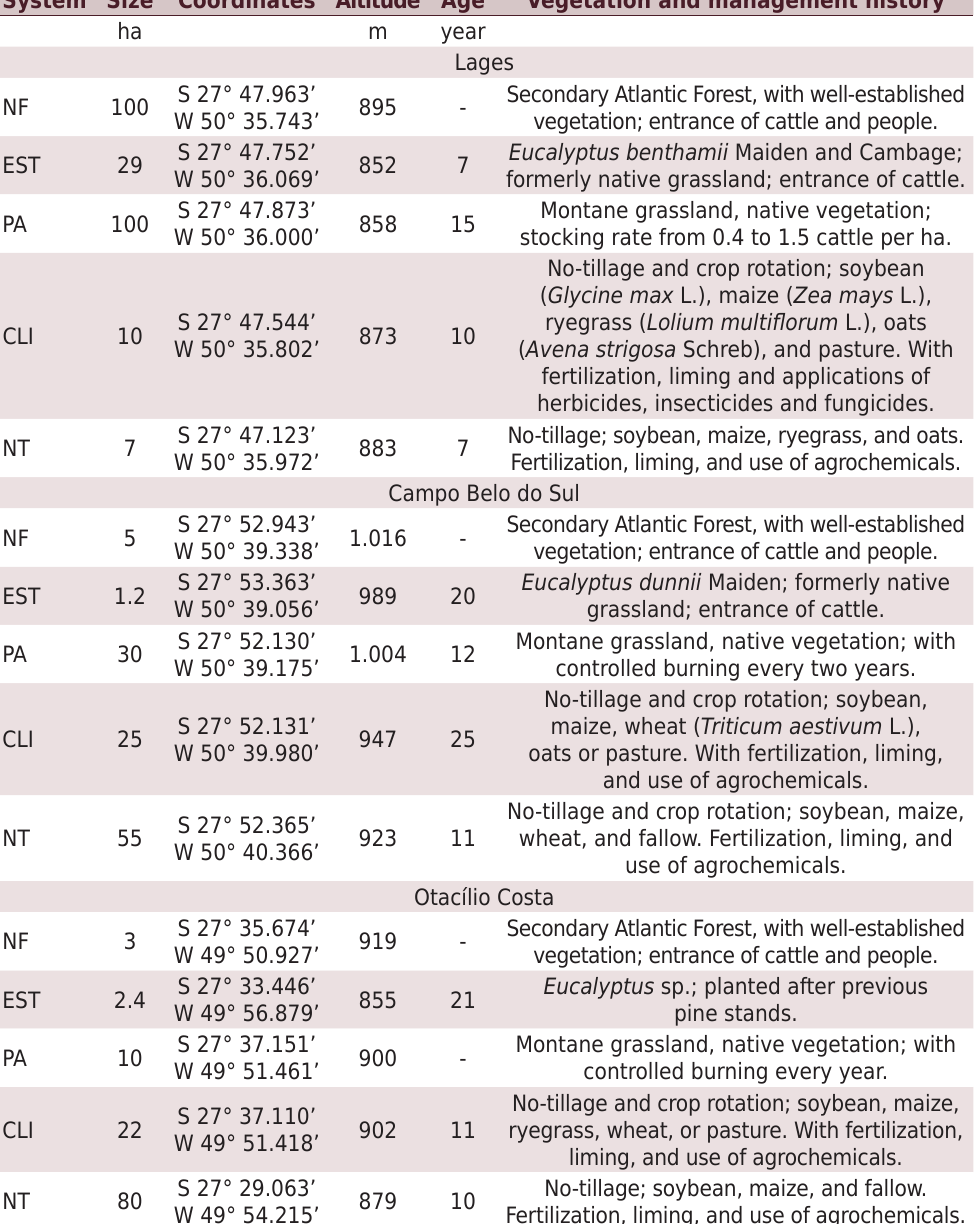
Table 1. Land use characteristics and history of native forest (NF), Eucalyptus stands (EST), perennial pasture (PA), crop-livestock integration (CLI), and no-tillage (NT) areas on the Southern Santa Catarina Plateau. Adapted from Bartz et al. (2014a) and Rosa et al. (2015) System Size Coordinates Altitude